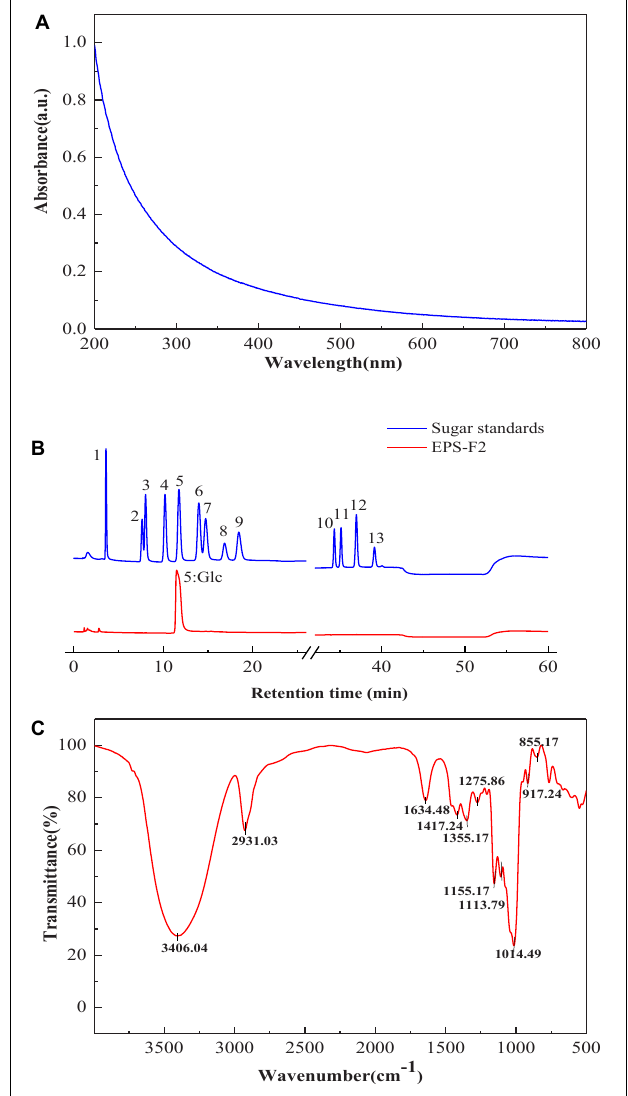
FIGURE 2 | (A) UV – vis absorption spectrum; (B) HPAEC-PAD profiles of monosaccharide standards and EPS-F2 (Peak identities:1, Fucose; 2, Rhamnose; 3, Arabinose; 4, Galactose; 5, Glucose; 6, Xylose; 7, Mannose; 8, Fructose; 9, Ribose; 10, Galacturonic acid; 11, Guluronic Acid; 12, Glucuronic acid; 13, Mannuronic acid.) (C) FTIR spectrum of EPS-F2